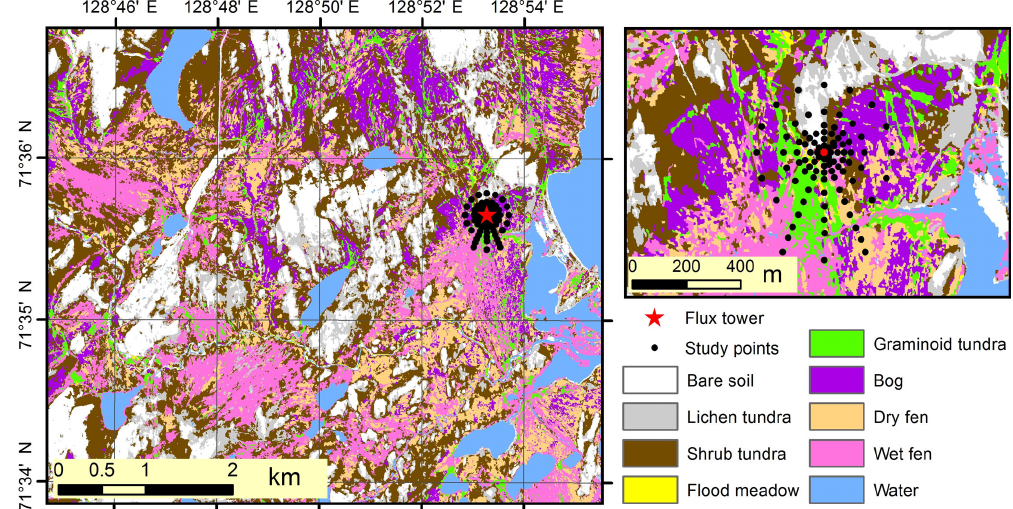
Figure 9. Land cover map of the study landscape. The nine land cover types were derived using a 2m resolution object-based classification, which utilized 109 features calculated from very-high-resolution satellite imagery and a digital surface